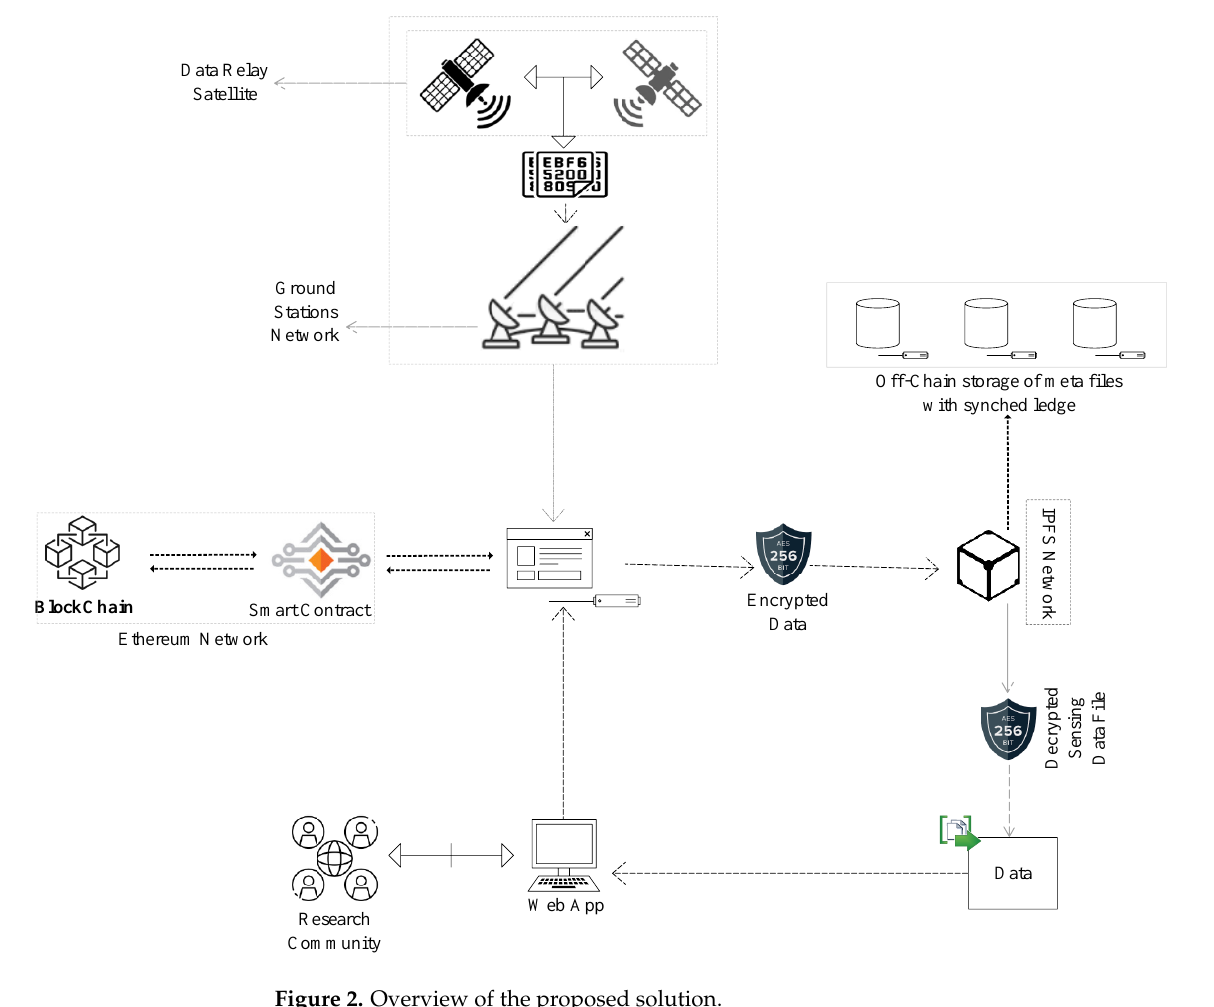
Figure 2. Overview of the proposed solution.